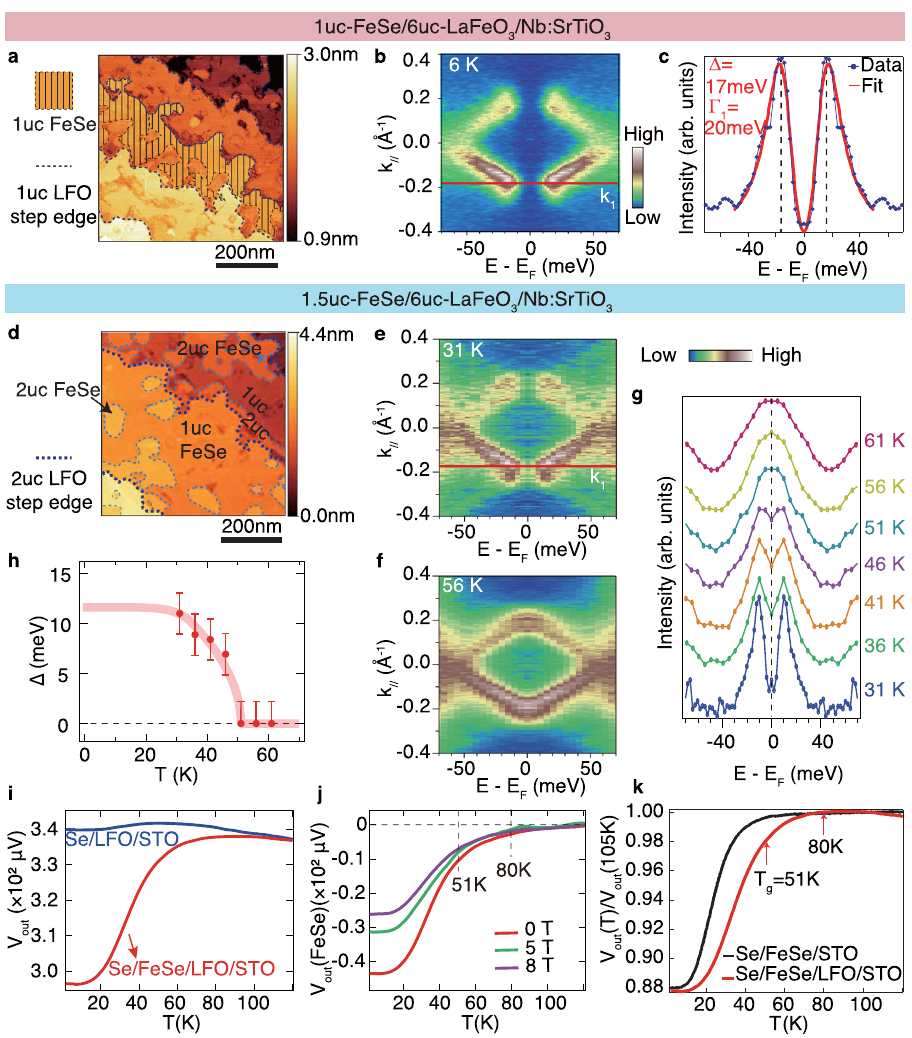
Fig. 3 Superconducting gap and mutual inductance measurements on FeSe/LFO/STO. a , d Surface morphology of the nominal 1uc FeSe/LFO/STO ( a , sample bias = 4 V, tunneling current = 30 pA), and 1.5uc FeSe/LFO/STO sample ( d sample bias = 2 V, tunneling current = 30 pA) measured by STM. Partial coverage of FeSe on one LFO terrace is illustrated as shaded area in panel a . b Symmetrized photoemission spectrum with respect to E F of the 1uc FeSe/LFO/STO across M measured with 1/8 I 0 at 6 K. c Symmetrized EDC at the k 1 ’ s of 1uc FeSe/LFO/STO and the fi tting to a superconducting spectral function based on the simpli fi ed Bardeen-Cooper-Schrieffer(BCS) self-energy 19,60 – 62 . e , f Symmetrized photoemission spectrum with respect to E F of the 1.5uc FeSe/LFO/STO across M measured at 31 and 56 K, respectively. g , h Temperature dependence of the symmetrized EDC at the k 1 ', and the determined superconducting gap of 1.5uc FeSe/LFO/STO, respectively. The error bars of gap are from the s.d. of the fi tting process and the measurement uncertainty. i Temperature dependence of the out-of-phase voltage V out in the pickup coil measured by the ex-situ mutual inductance experiments on the a -Se capped 1.5uc FeSe/LFO/STO and a comparative sample of Se capped LFO/STO with the same heat treatment. j Diamagnetic signal of FeSe in varied magnetic fi eld. V out (FeSe) is obtained by the subtraction of V out (Se/1.5uc FeSe/LFO/STO) by V out (Se/LFO/STO) in i . k Comparison between V out (Se/1.5uc FeSe/LFO/STO) in this work and V out (Se/2uc FeSe/2uc (Fe 0.96 Co 0.04 )Se/1uc FeSe/STO) in Zhang et al. 7 normalized by the corresponding 105K